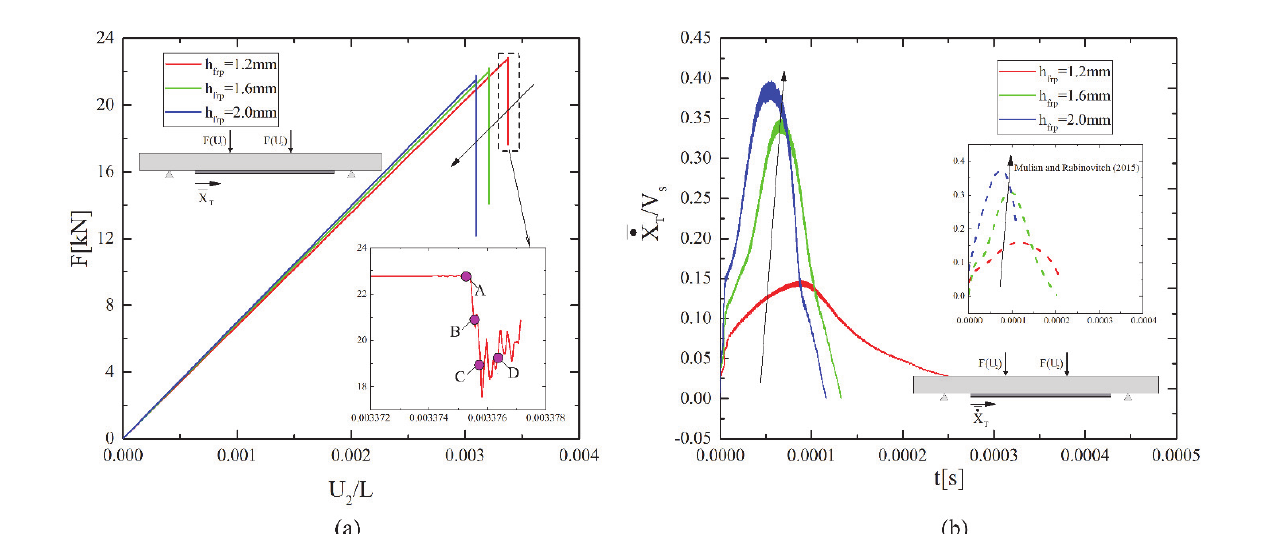
Figure 7: Comparisons in terms of loading curve for different thickness of the FRP strip (a); Comparisons in terms of time histories of the debonding front speed for different thickness of the FRP strip (b).